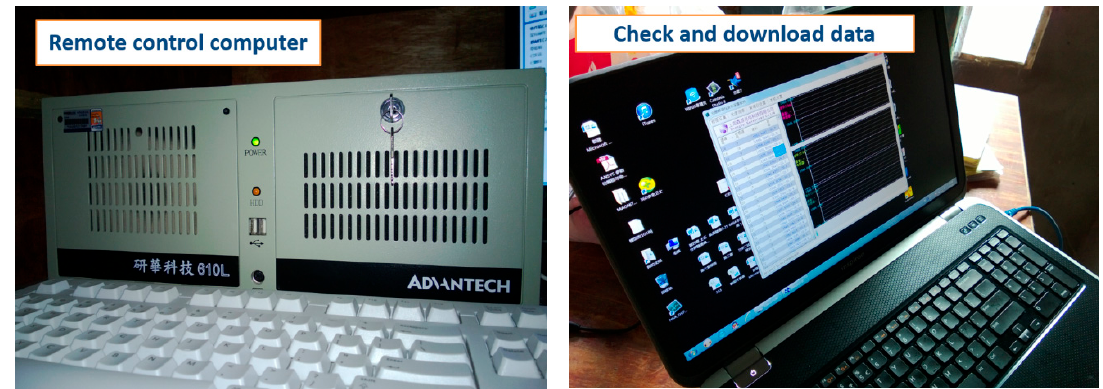
Figure 7. FBG demodulators.